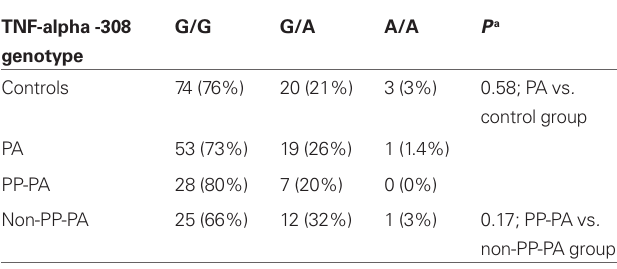
Table 2 | Genotype frequencies of the TNF-alpha -308 polymorphism in children with signs of premature adrenarche (PA) and in control